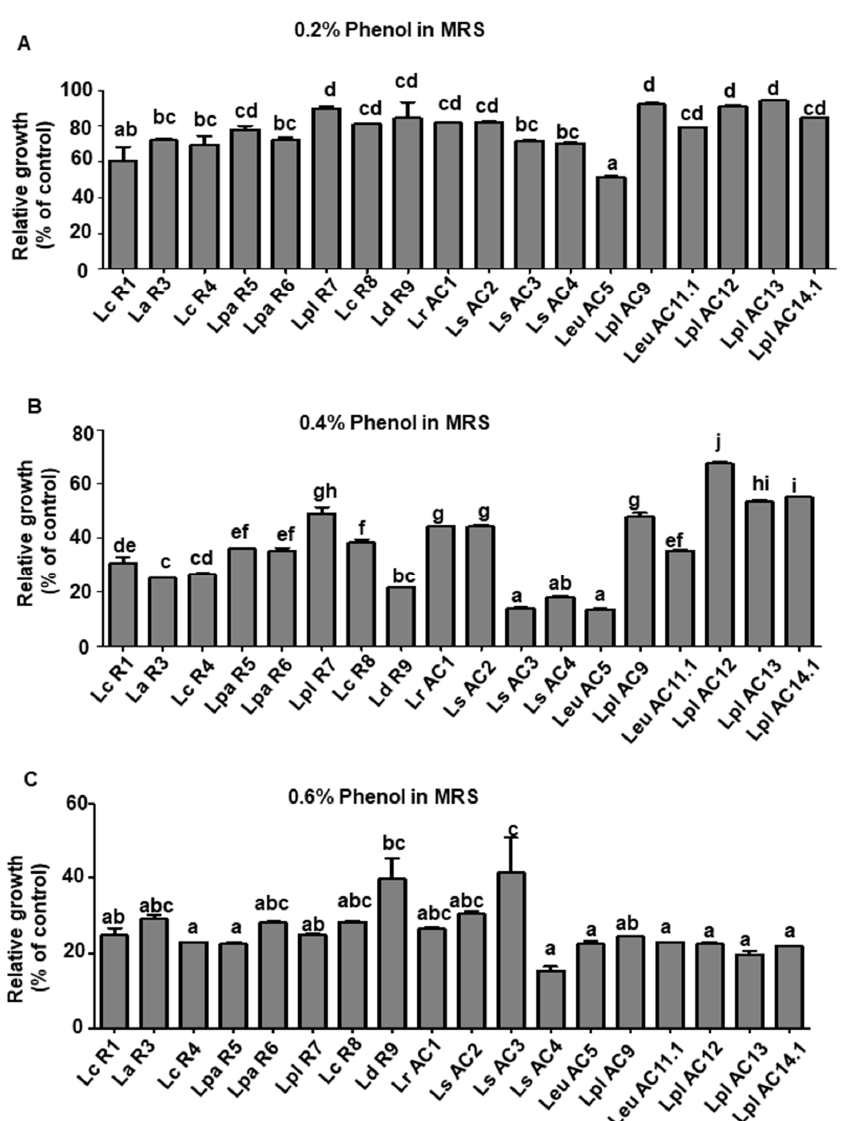
Figure 4. Relative growth of selected LAB isolates in the MRS broth supplemented with 0.2% ( A ), 0.4% ( B ), and 0.6% ( C ) phenol after 24 h of incubation. Relative growth was determined by the ratio of OD 600 of LAB cultures grown in the MRS containing different concentrations of phenol to that in the regular MRS. Graph bars marked with different letters on top represent statistically significant results. The results were compared by one-way ANOVA and Turkey post hoc test; p < 0.05; n = 2. Lc, L. casei; La , L. acidophilus; Lpa , L. paracasei; Lpl , L. plantarum; Ld , L. delbrueckii; Lr , L. rhamnosus; Ls , L. sakei; Leu , Leu.